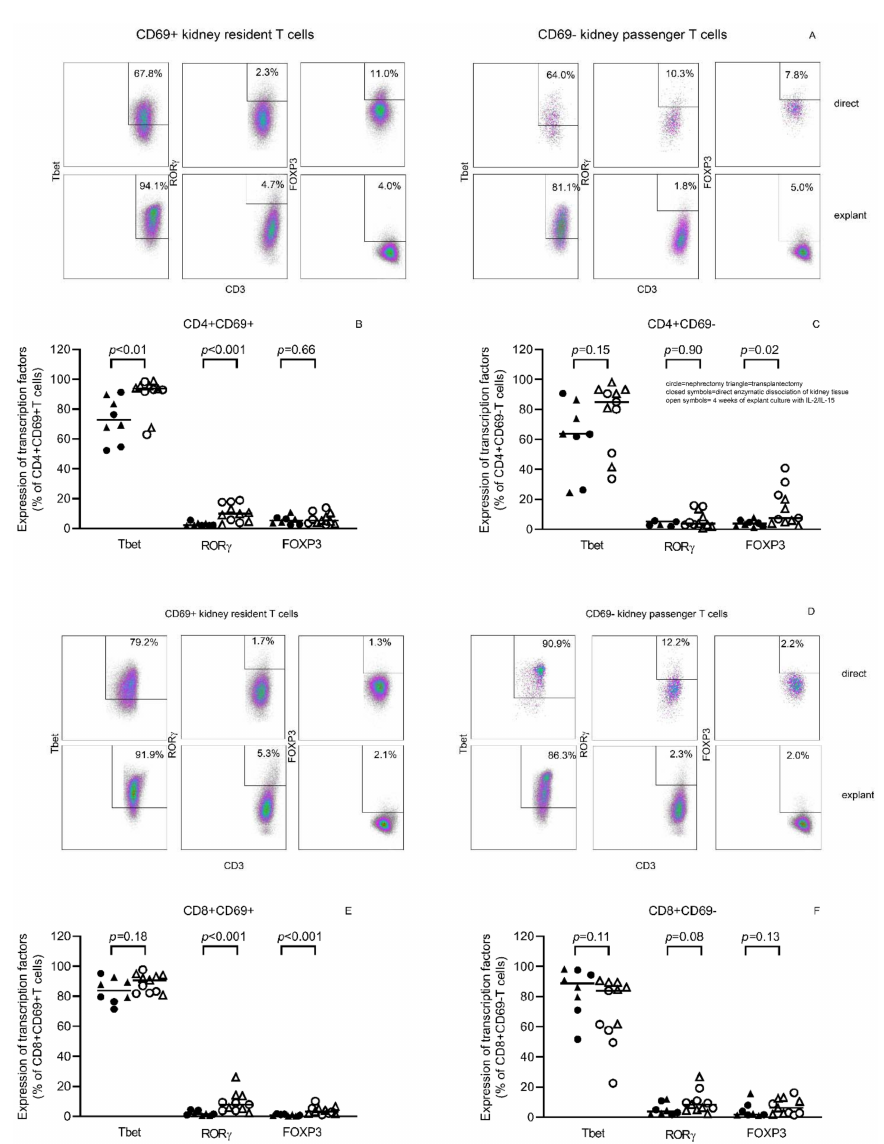
Figure 6. T cells harvested from explant culture in the presence of exogenous IL-2 and IL-15 showed increased expression of the Th1 transcription factor Tbet compared to T cells obtained following direct enzymatic processing of kidney tissue. In ( A , D ), a typical example of the flow cytometric gating strategy for analysis of expression of transcription factors of CD4+ ( A ) and CD8+ ( D ) T cells